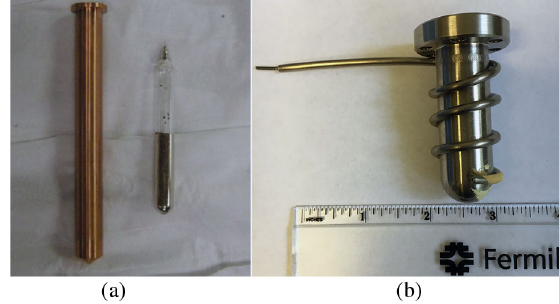
FIG. 9. (a) Cesium oven made of copper (left) and vial with 5 g of elemental cesium (right). (b) New cesium oven made of stainless steel with 2 Ω = m heating wire around